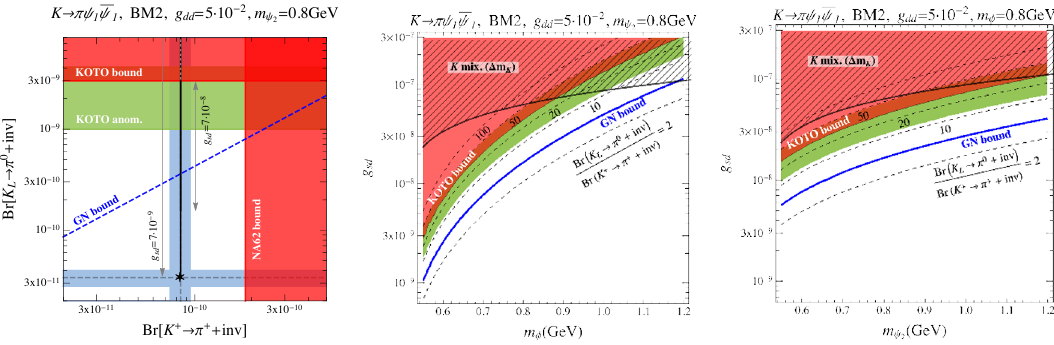
Figure 20 . Same as (cid:12)gure 19 but for Model 3 BM2. In the predictions for Br( K + (cid:25) 0 + inv) in the left plot (black lines) we vary m (cid:30) Br( K L ! g sd = 7 10 (cid:0) 9 ; 7 10 (cid:0) 7 and (cid:12)x m (cid:1) (cid:1)